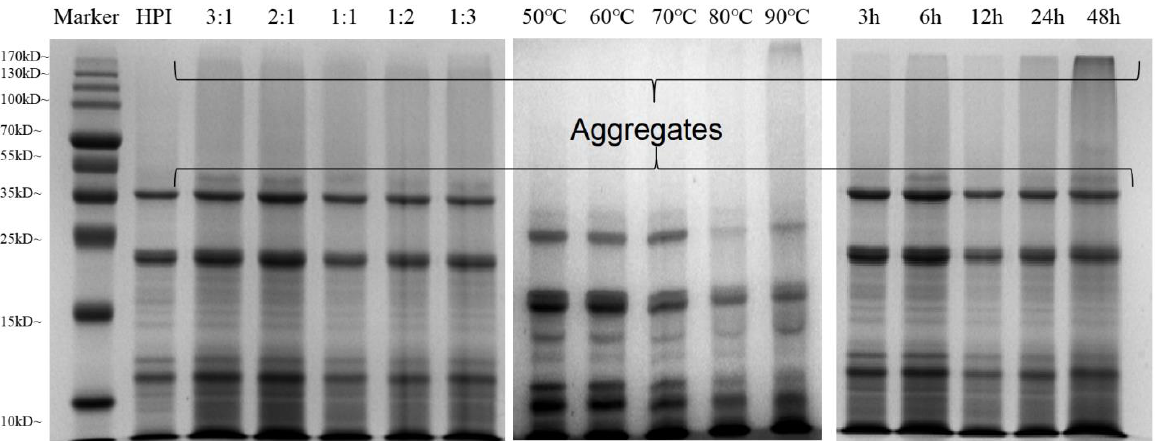
Figure 2. SDS-PAGE analysis of native hemp protein and glycosylated HPI–pullulan prepared under different conditions.